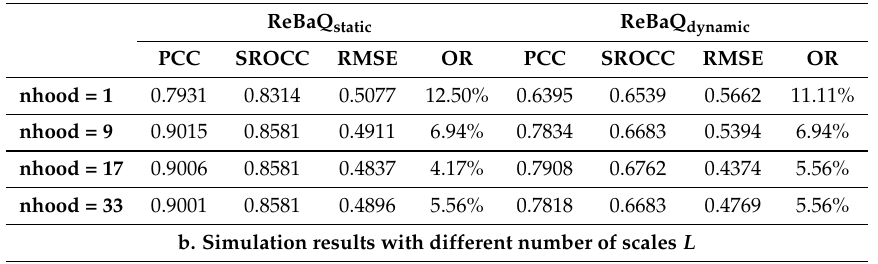
Table 4. Performance comparison for different values of parameters on the ReBaQ dataset. a. Simulation results with different neighborhood search window sizes nhood .